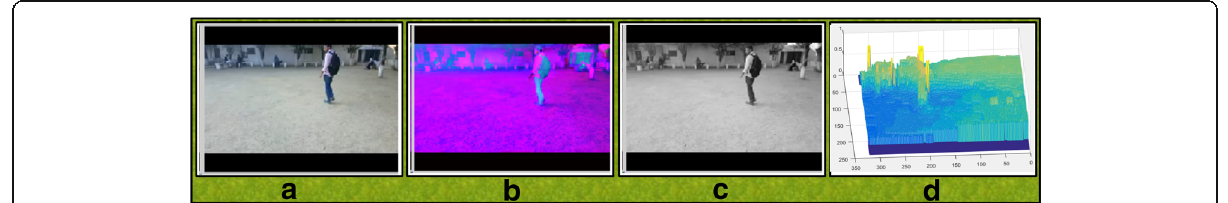
Fig. 3 Preprocessing results. a Original frame. b Contrast stretching. c Hue channel. d Mesh